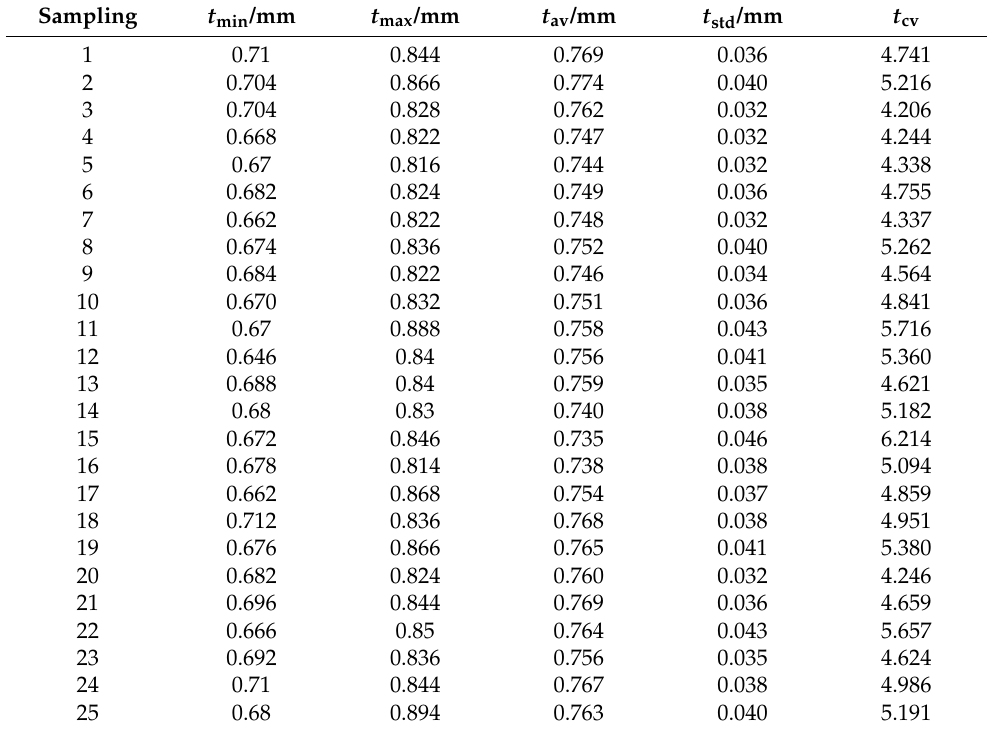
Figure 3. Dimensional comparison of 3D scanning: ( a ) 7# model; ( b ) 8# model; ( c ) 10# model. Table 1. Results of thickness measurement in the main body.